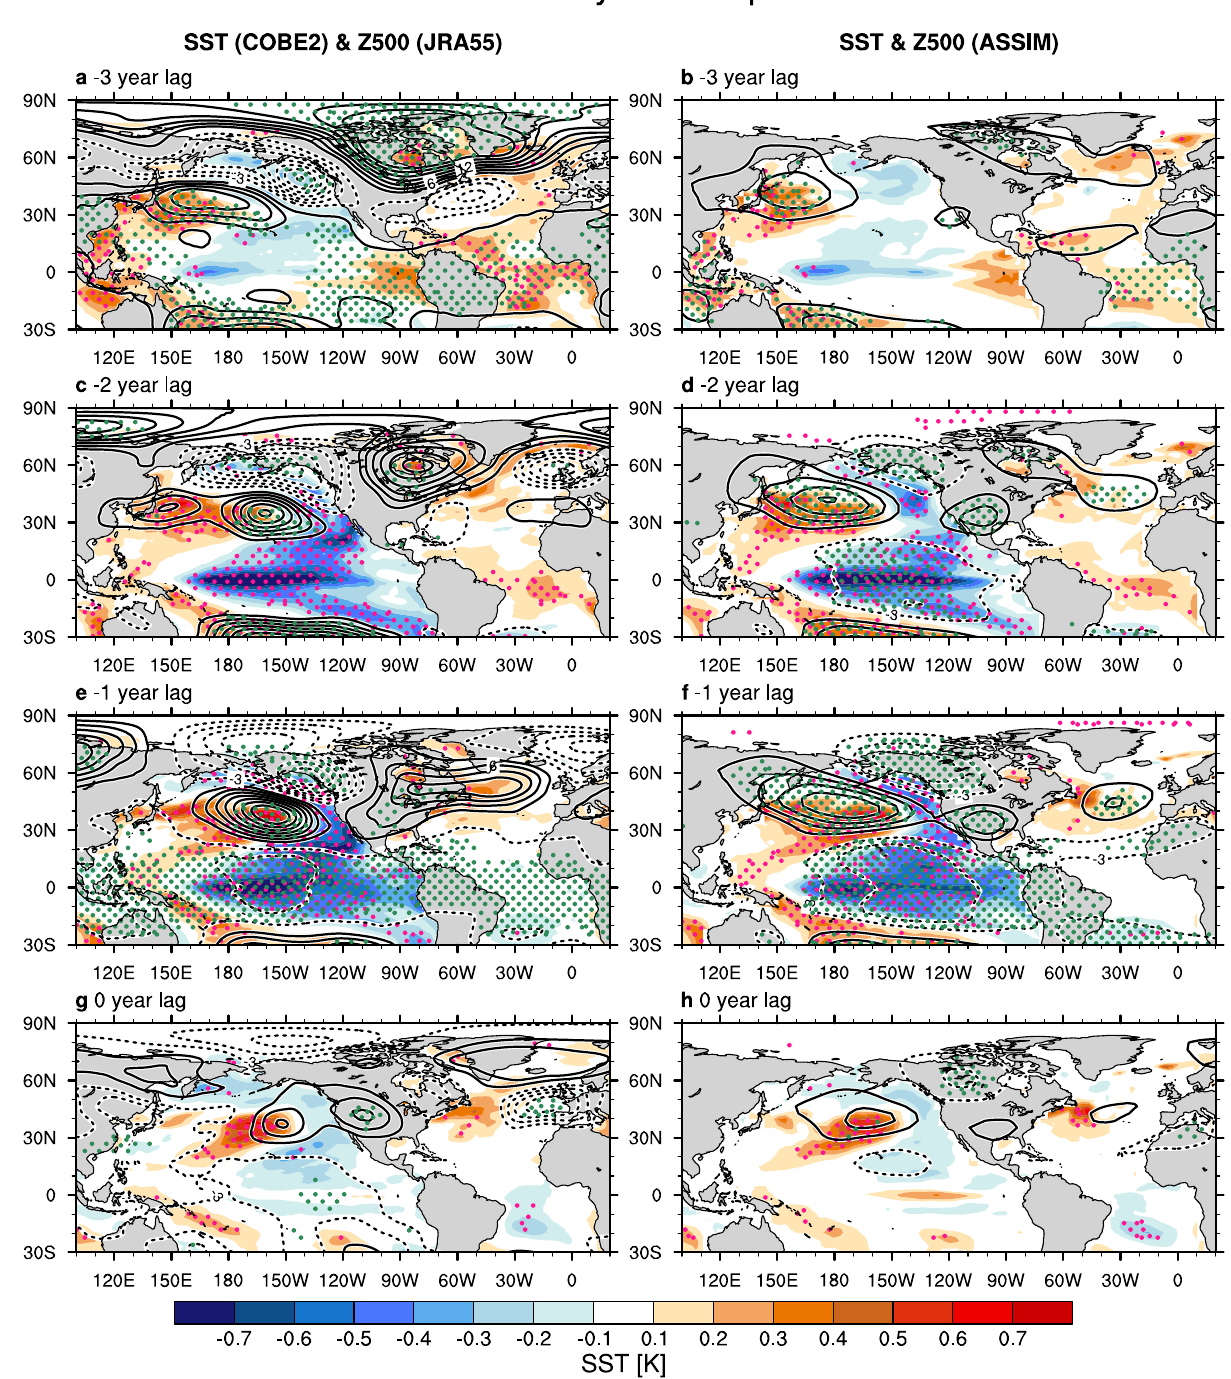
Fig. 4 Predictable atmosphere-ocean anomalies associated with water shortages of the Colorado River. Composite maps of annual mean SST (shaded) and 500 hPa geopotential height anomalies (contours) in observations (left) and the ASSIM run (right) during drought years in the model (i.e., 1963, 1976, 2000, 2001, 2002, 2012, and 2013; see Supplementary Fig. 2) at a , b − 3, c , d − 2, e , f − 1, and g , h 0 year lags. Anomalies are de fi ned as deviations from climatological means and linear trends are removed in each grid. Contour intervals are ±3, ±6, ±9, ±12, ±15, ±18, and ±21 hPa. Zero contours are omitted and negative values are dashed. Pinks (greens) indicate the statistical signi fi cance at the 90% levels with two-side Student ’ s t -test for SST (geopotential height)